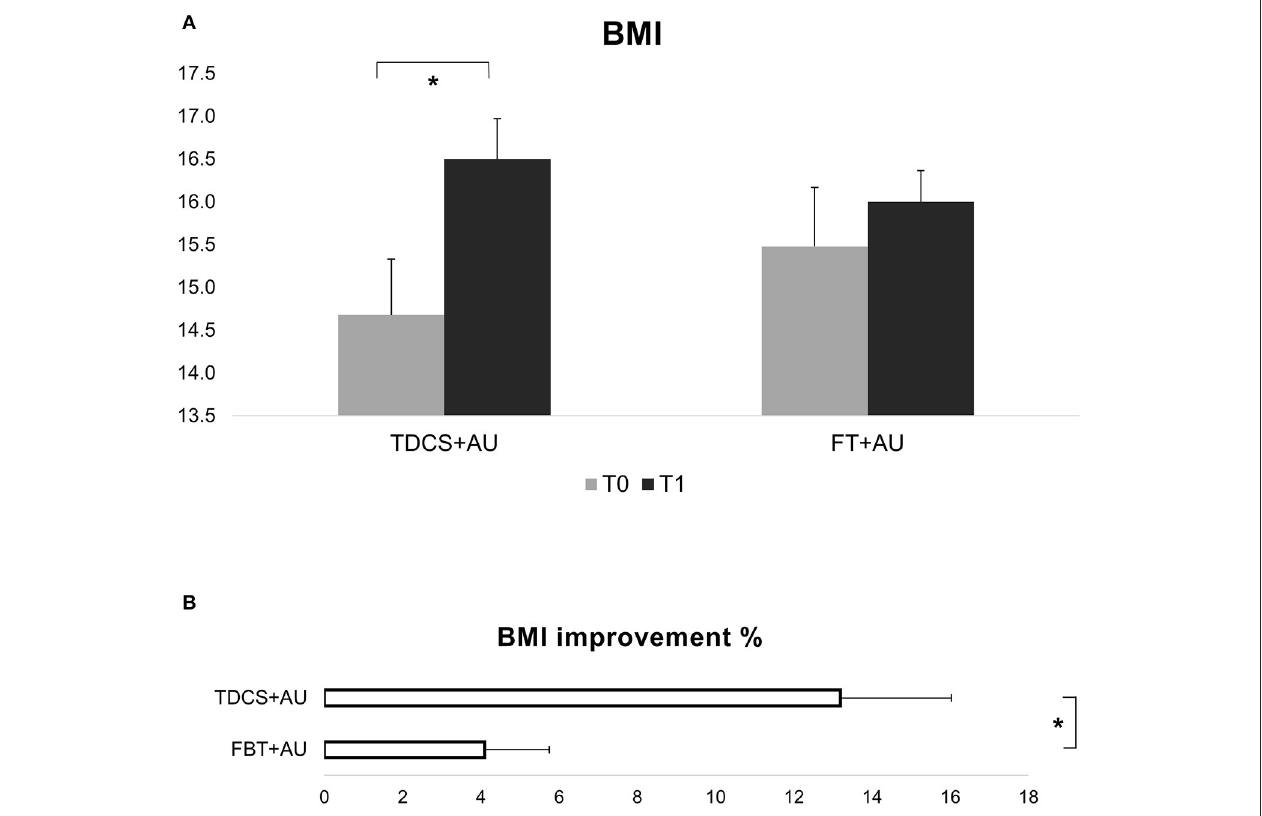
FIGURE 1 | (A) Shows BMI values expressed in mean at baseline (T0) and after the end of treatment (T1). In the tDCS + AU group BMI values increased significantly more than in the FBT + AU group. (B) Shows the percentage of increase [(T1-T0/T0)*100]: in the tDCS + AU group it amounted to 13.3% ( ± 9.4) while in the FBT + AU group it amounted to 4.2% ( ± 5.7). * p <